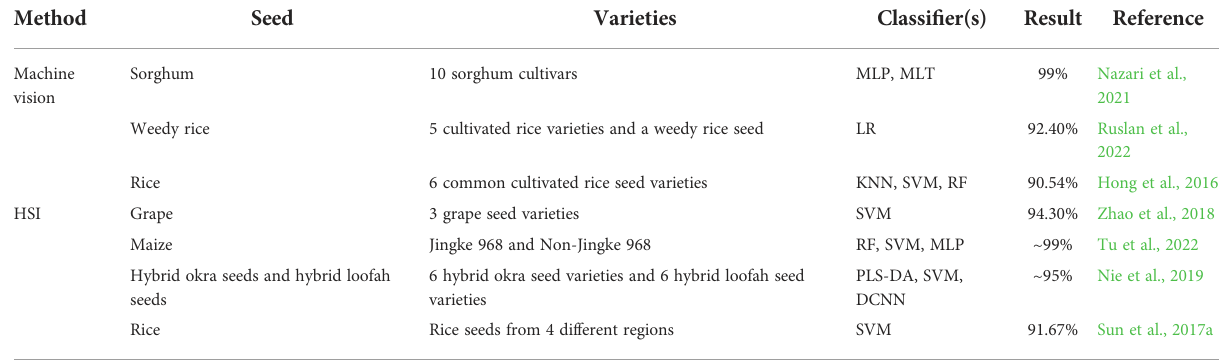
TABLE 1 Application of machine vision and HSI for different crop seed classi fi cation tasks. Method